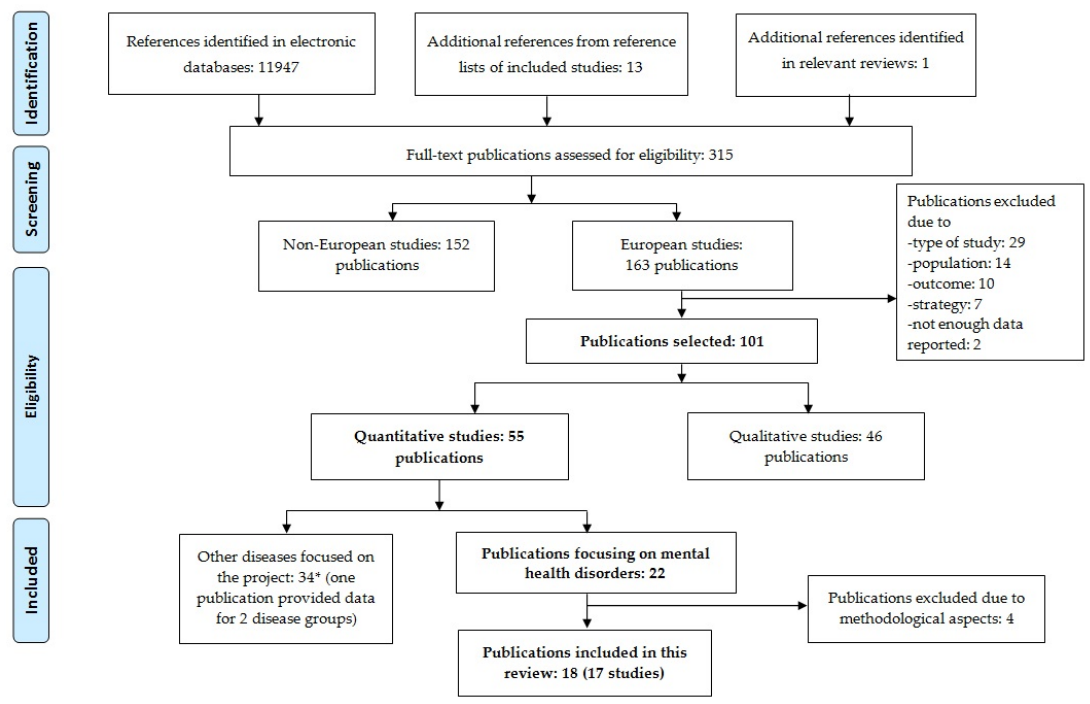
Figure 1. Flow chart of the systematic review carried out in the PATHWAYS project. Boxes in bold highlight the flow chart of the present review, assessing employment strategies for persons with